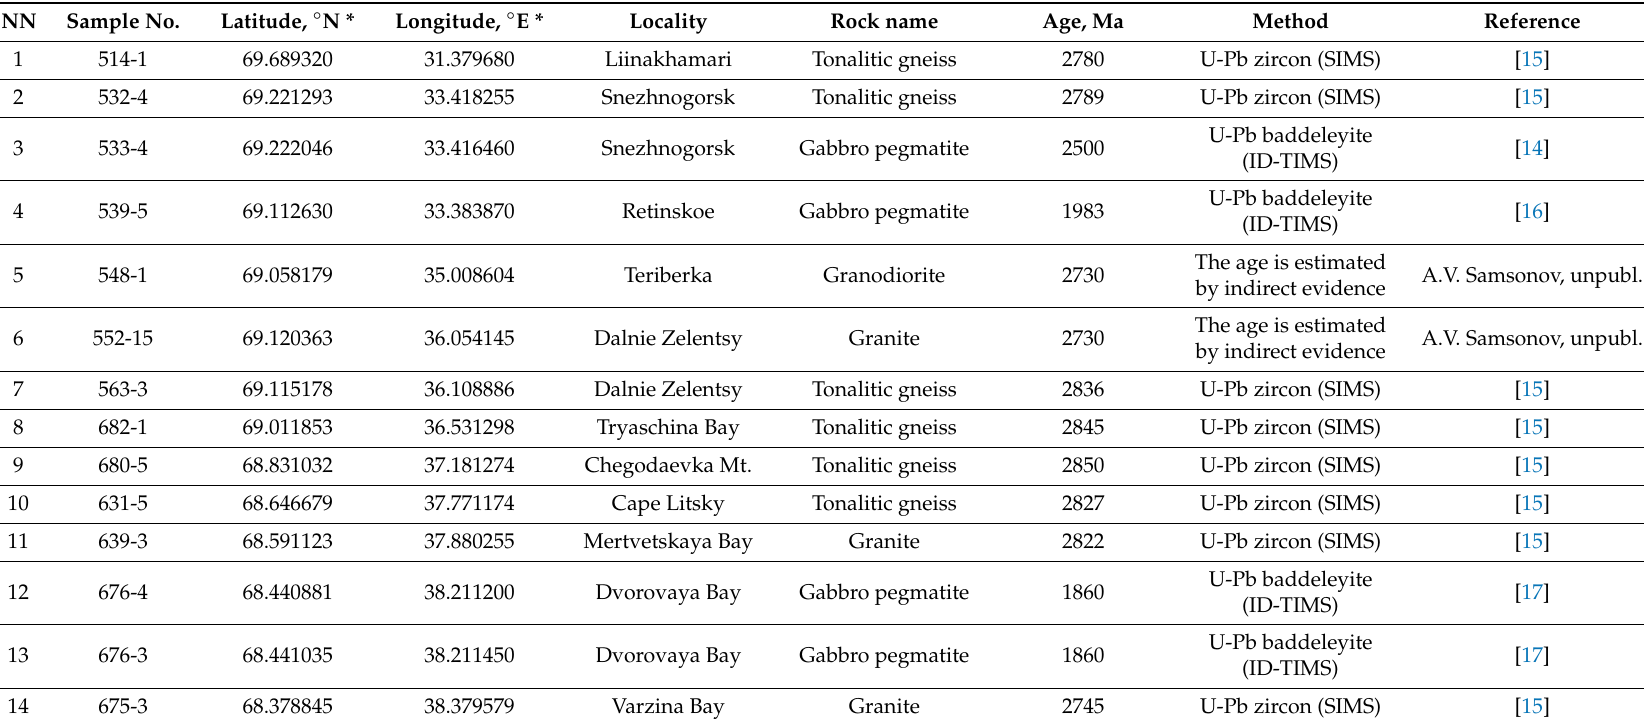
Table 1. Samples used for apatite fission-track